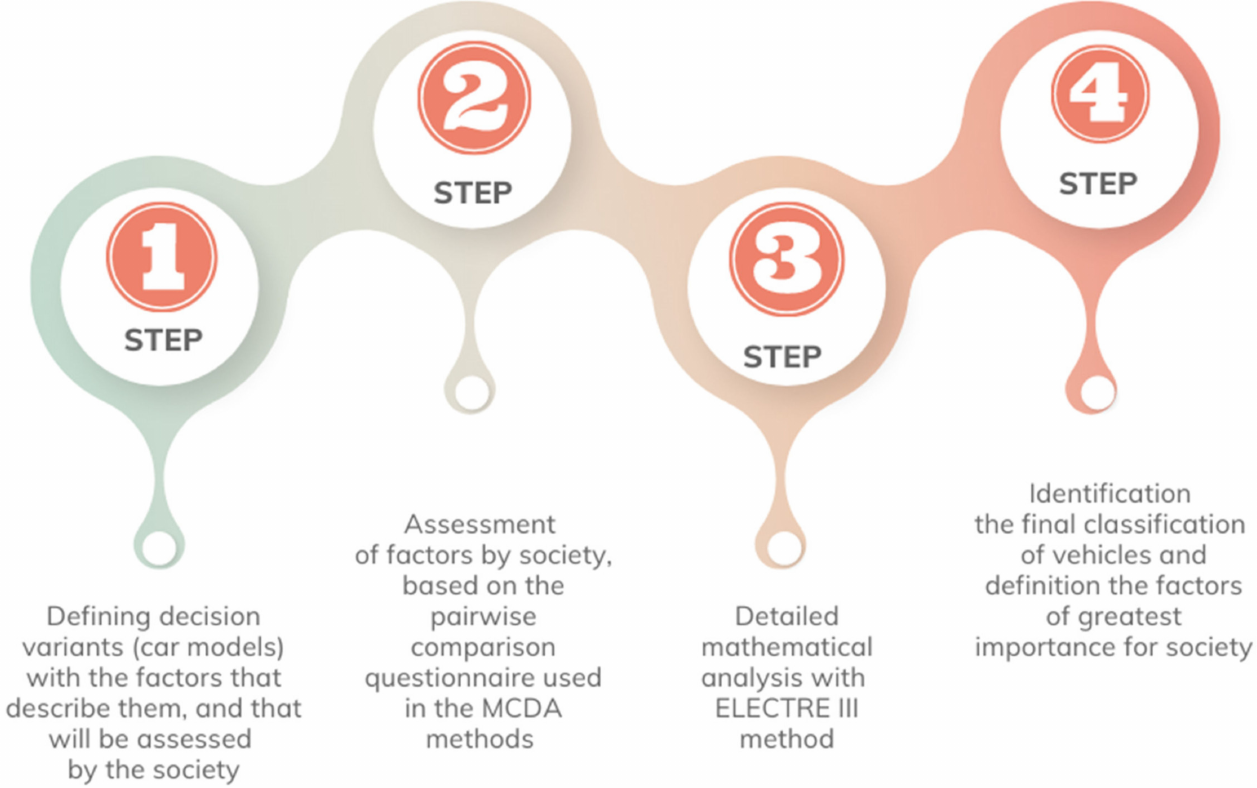
Figure 1. Research